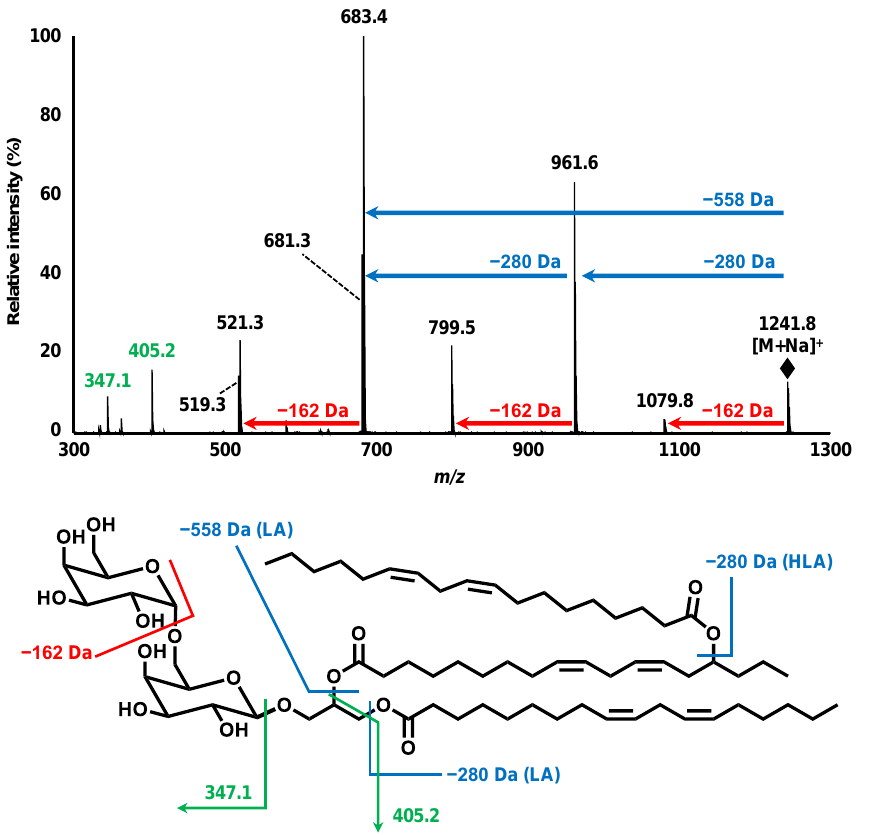
Figure 3. MS/MS spectra of product ion scan analysis of m/z 1241.826. Analytical conditions are de-